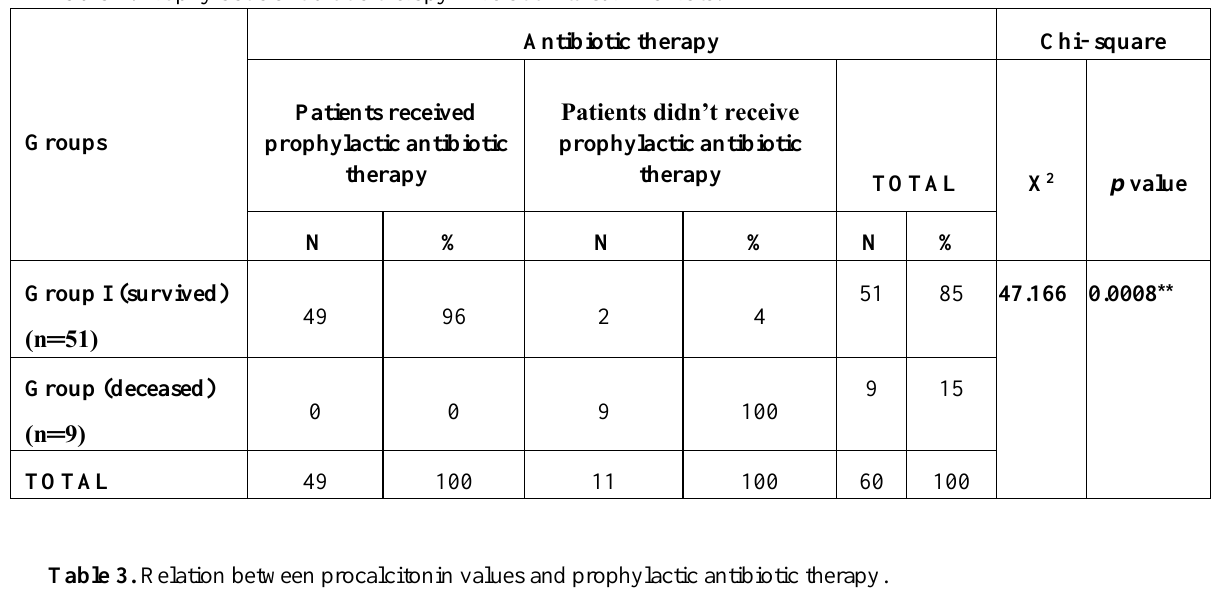
Table 2. Prophylactic antibiotic therapy in relation to survival rate.